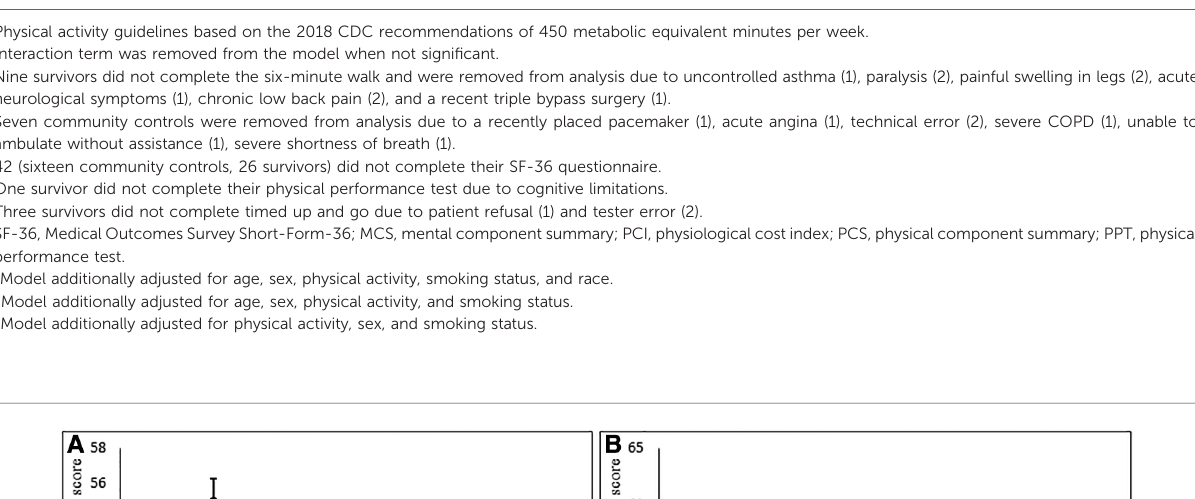
PCI*group, survivor